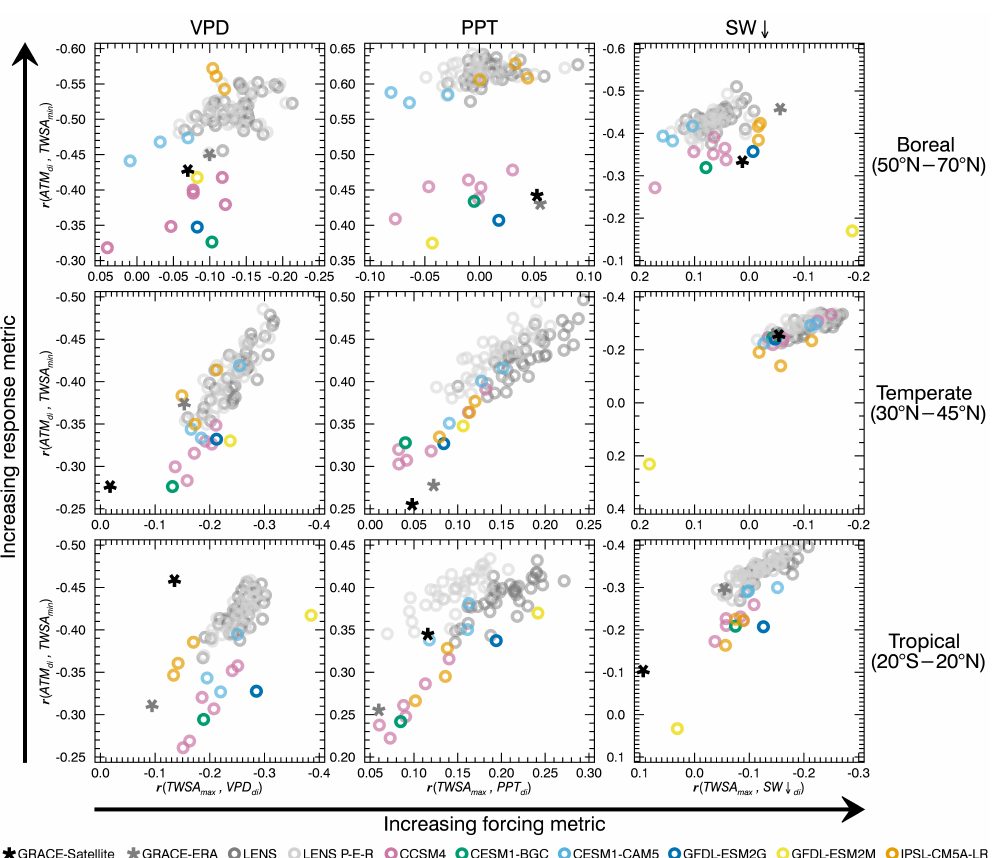
Figure 10. Scatter plots of forcing and response metrics for LENS and CMIP5 models with observations, averaged across land regions within different latitude bands. For LENS, we show metrics calculated using the explicit TWS output (darker gray) and TWSA estimates from the accumulated residuals of the surface water balance (lighter gray). For CMIP5 models, we calculated metrics using TWSA estimates from the accumulated residuals of the surface water